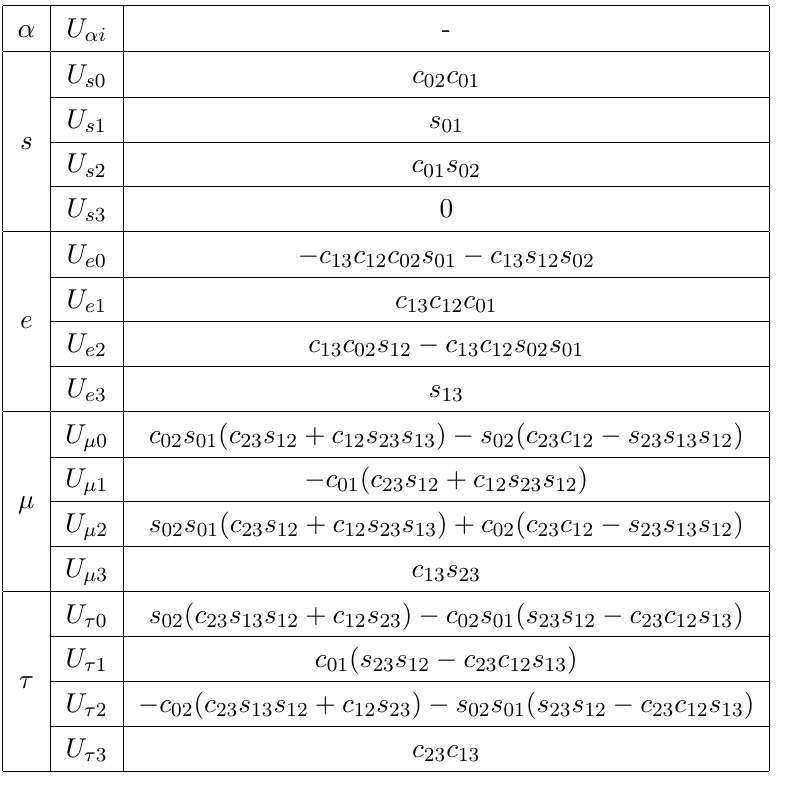
Table 2 . The elements of the mixing matrix in the 3+1 framework. Here, the mixing angle θ 03 and all phases are assumed to be